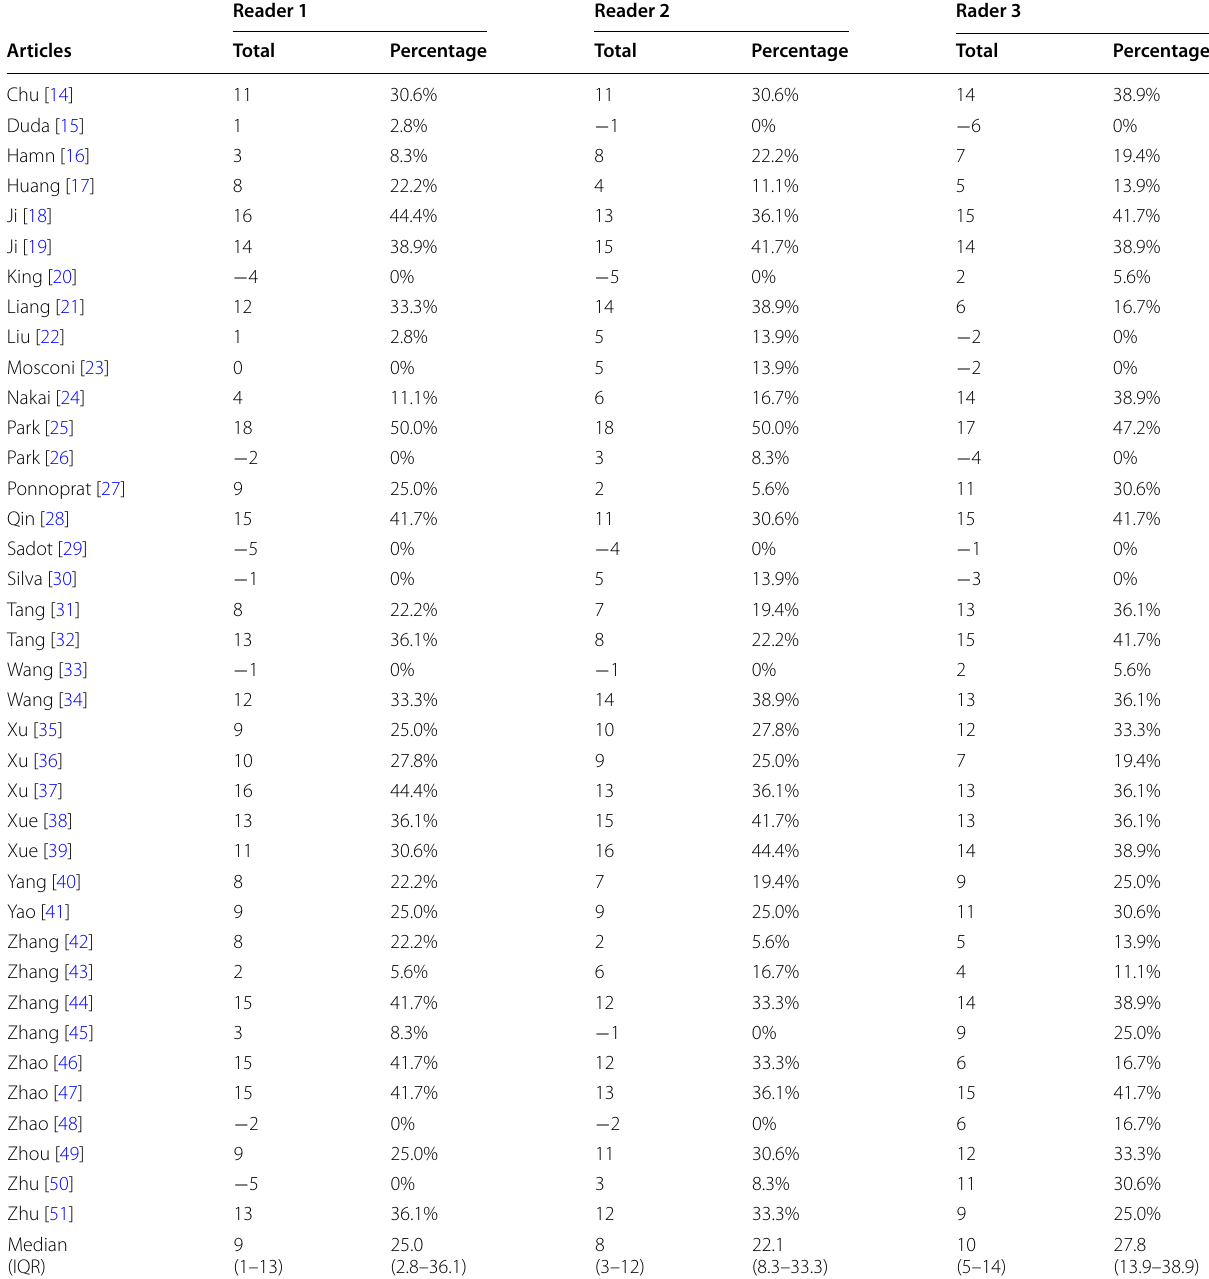
Table 3 Total radiomics quality score (RQS) with percentage of the total score of the included studies assessed by three